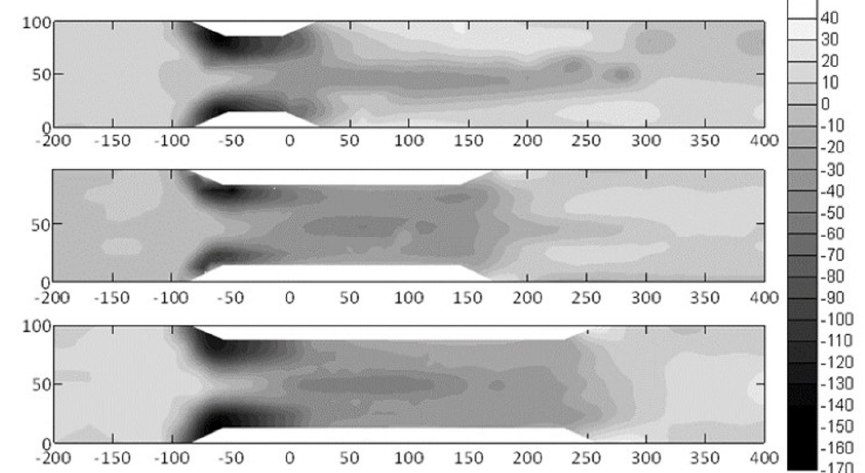
Figure 2. Comparison of bed morphologies observed at the end of runs 16 ( map at the top ), 14 ( map in the middle ), and 20 ( map at the bottom ). All the runs lasted 8 hours and were characterized by the same approach flow conditions and mobile bed, but different contraction length equal to 0.5, 2.00, and 3.00 m, respectively. Axis coordinates are in cm while measurements in mm.